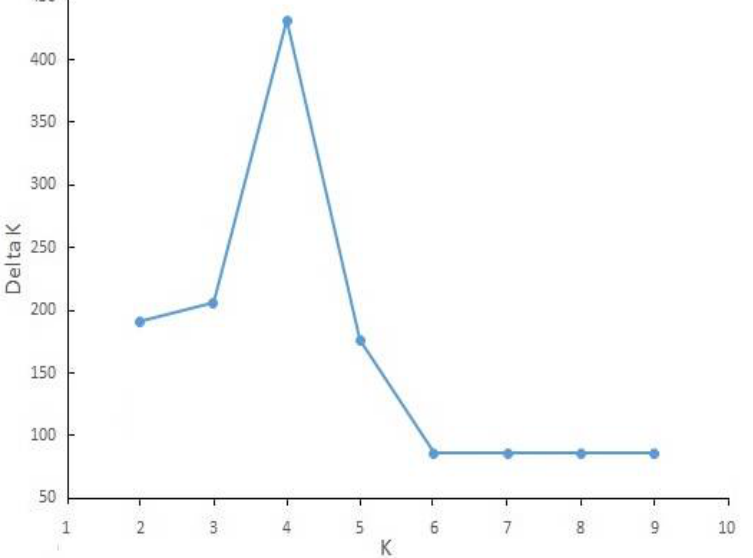
Figure 5. ∆ K output from the structure harvester for Meloidogyne javanica in the present Figure 5. ΔK output from the structure harvester for Meloidogyne javanica in the present study.